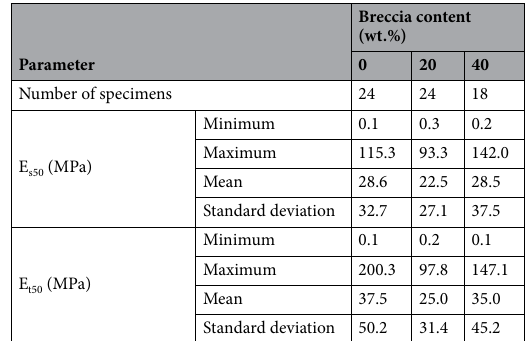
Breccia content (wt.%)